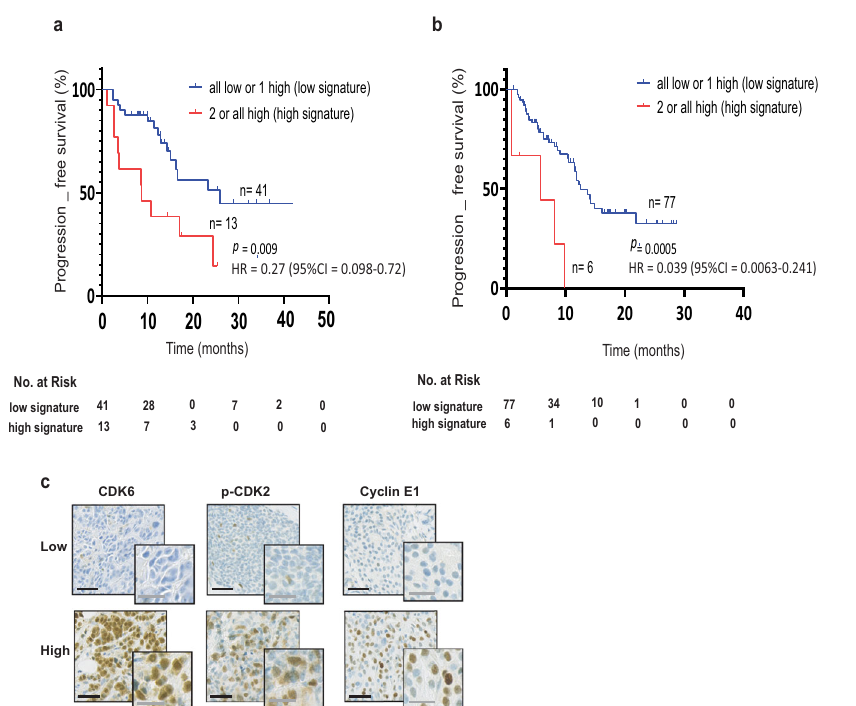
Fig. 7 High expression of CDK6, p-CDK2, and/or cyclin E1 is associated with low progression-free survival in ER + ABC patients treated with AI-monotherapy or combined CDK4/6i and ET. Kaplan – Meier plots evaluating PFS according to a combined score based on the levels of three biomarkers CDK6, p-CDK2, and cyclin E1, in ER + metastatic lesions from BC patients in the advanced setting. a Cohort of patients receiving AI-monotherapy. b Cohort of patients treated with combined CDK4/6i and ET. The cutoff values used were: CDK6 H -score > 0, p-CDK2 H -score ≥ 75, and cyclin E1 H -score ≥ 100. A two-sided p -value calculated using log-rank testing is shown. c Representative micrographs of immunohistochemistry analysis of all breast cancer metastasis sections showing low or high CDK6, p-CDK2 and cyclin E1 expression (black scale bar: 100 µm, gray scale bar: 50